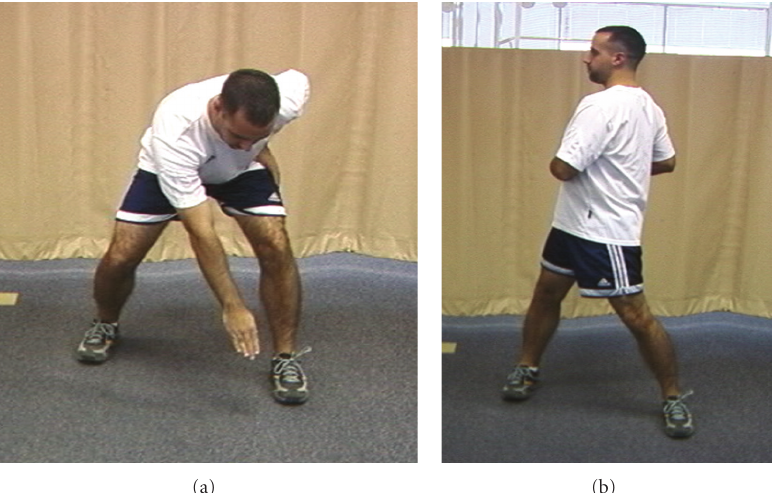
Figure 5: (a) Starting position for the lawnmower maneuver. (b) This exercise accentuates scapular external rotation through the use of the transverse